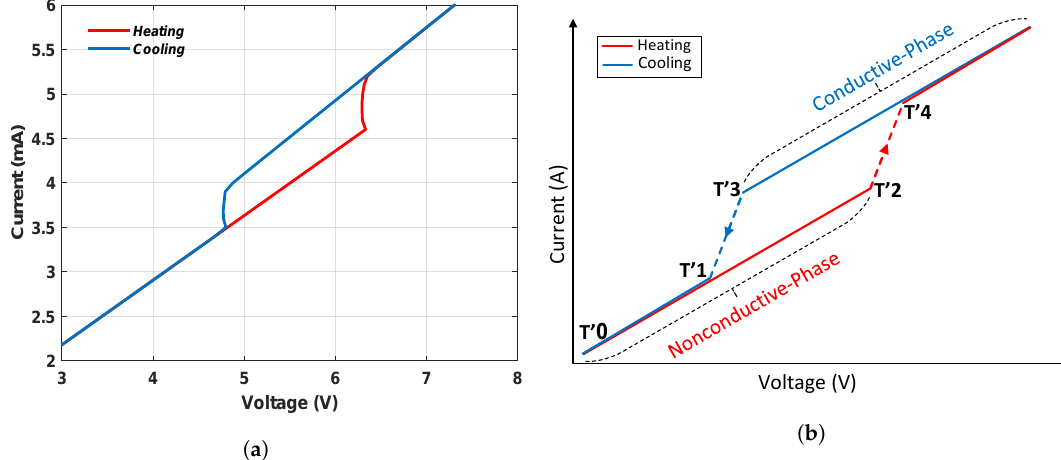
Figure 9. V-I curve of VO 2 vertical structures: ( a ) simulation example, r = 10µm, h = 60nm, and ambient temperature is 50 ◦ C and ( b ) the general shape for all other